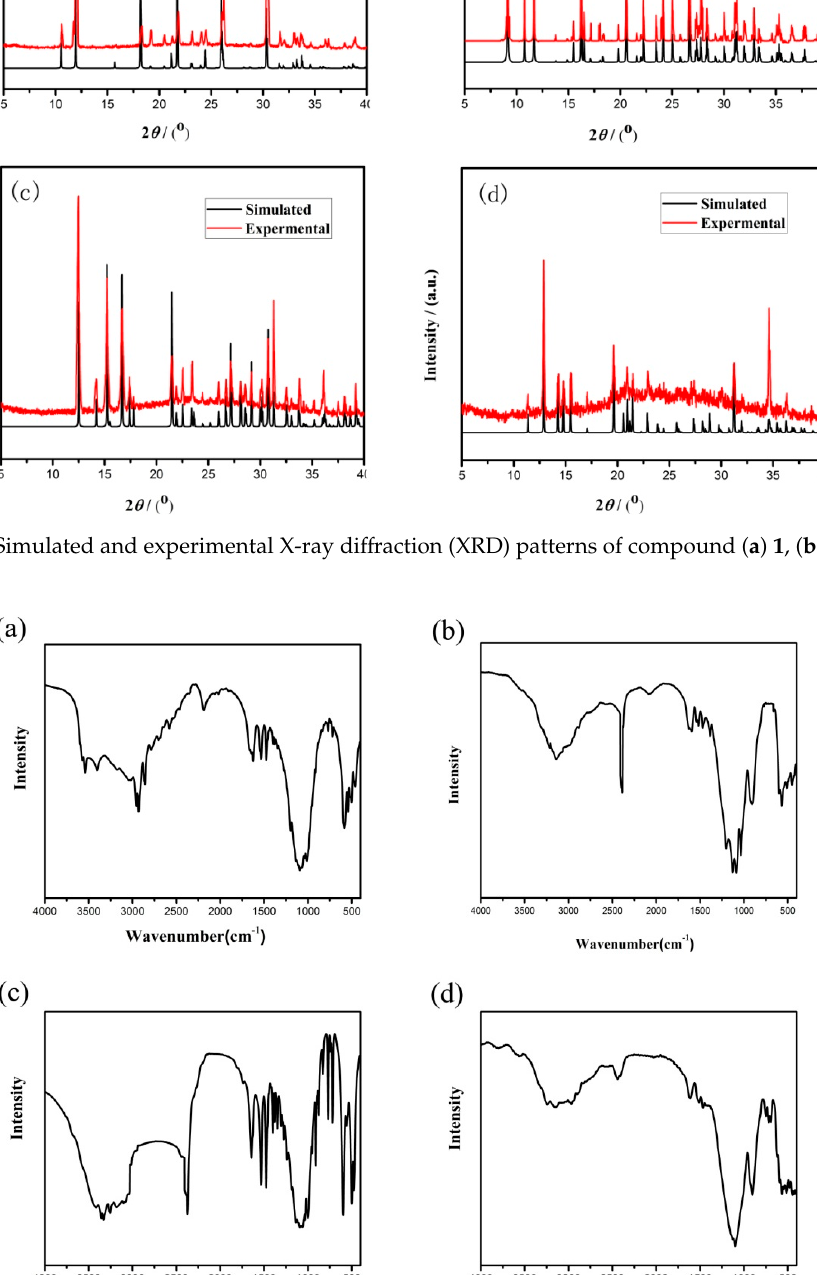
Figure 3. Infrared (IR) spectra of compound ( a ) 1 , ( b ) 2 , ( c ) 3 , and ( d ) 4 .